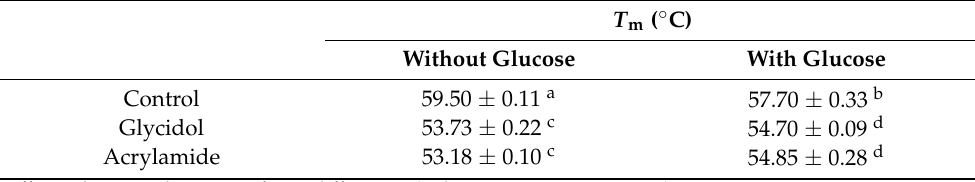
Table 3. Melting temperature of hemoglobin in the presence of glucose and glycidol or acryla- mide.